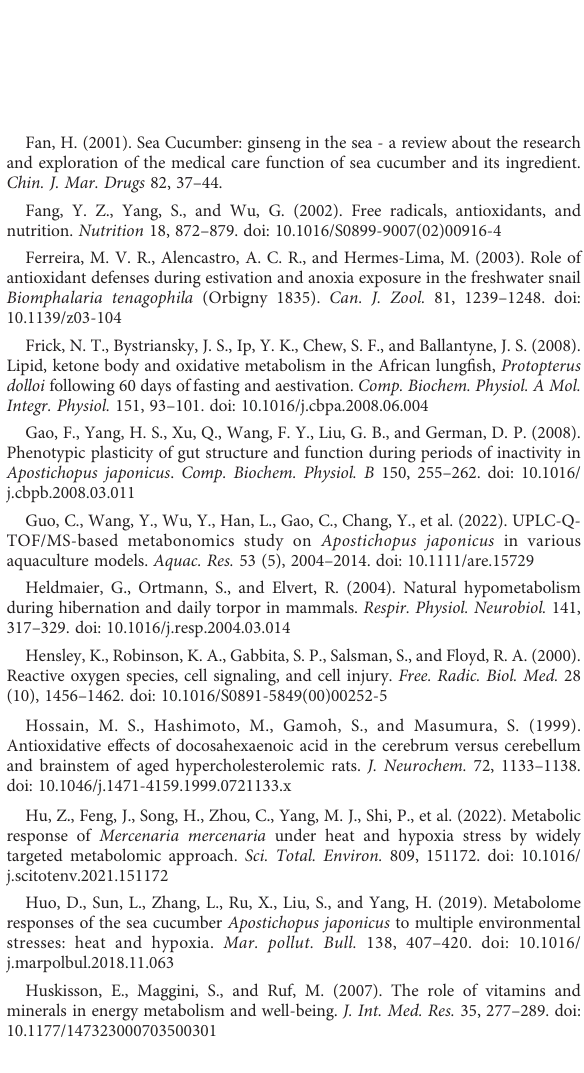
SUPPLEMENTARY FIGURE 2 PCA diagram of quality control analysis. SUPPLEMENTARY FIGURE 3 The permutation tests of OPLS-DA